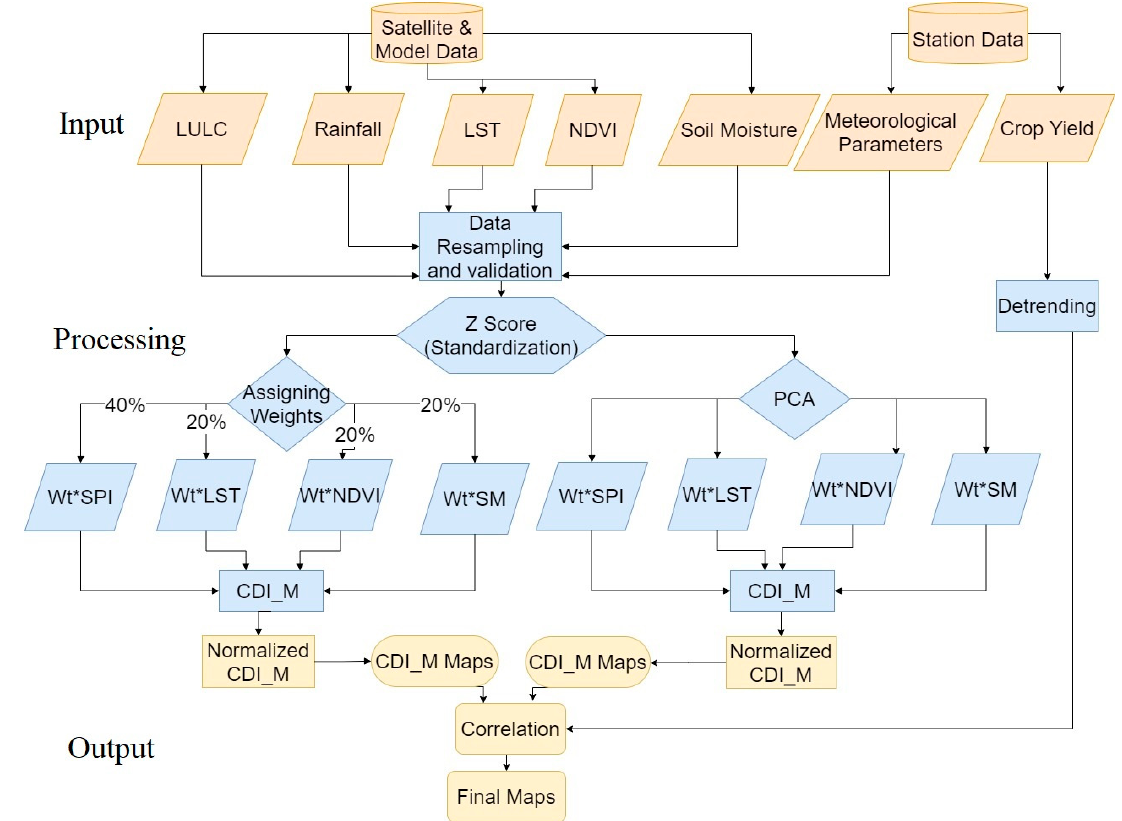
Figure 4. The general flow of methodology followed for this study.